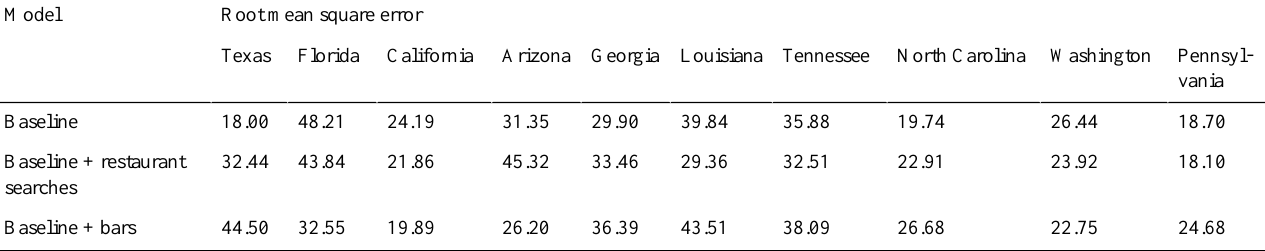
Table 5. Root mean square error scores for the time series of new COVID-19 cases (baseline), the baseline + restaurant searches time series, and the baseline + bar searches time series for the 10 US states and territories with the most daily new cases from April 9 to July 7,